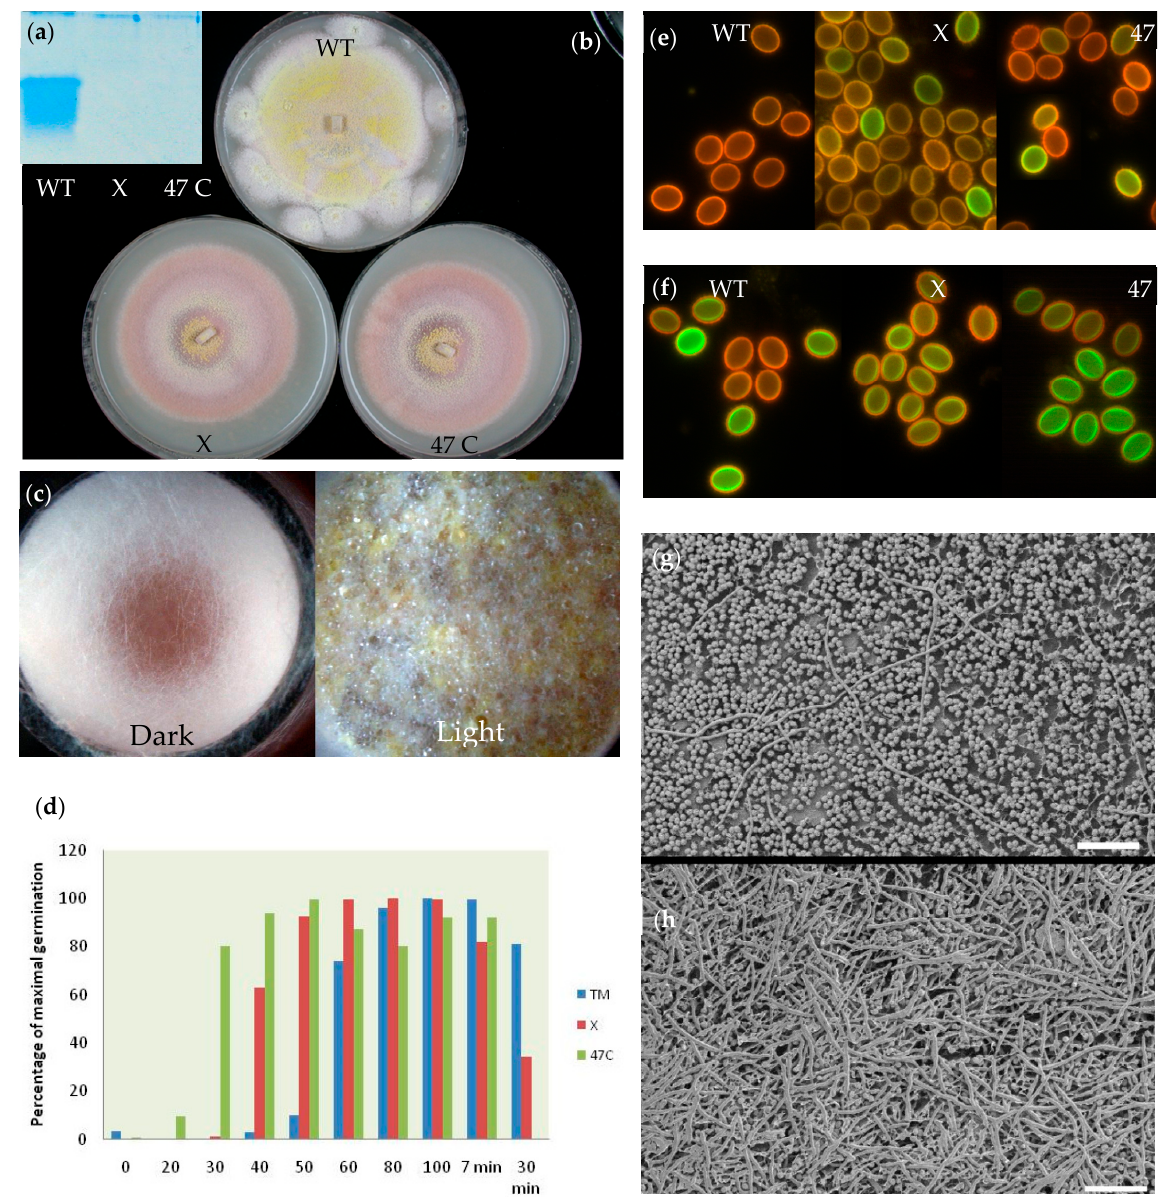
Figure 5. Properties of ICARUS mutants ( a – h ) ( a ) No protein was observed in the supernatant of mutant ascospores after heat activation. ( b ) Agar surfaces show different morphology of colonies of the wildtype in comparison with the mutant strains after 8 days of growth. Mutant colonies show later formation of ascomata (visible as yellow dots) and exhibit a red color due to a pigment which is also released into the agar. ( c ) Growth of mutant 47 C on oatmeal medium in the dark does not show the presence of ascomata after 8 days of incubation. Microtiter plates were wrapped in tin foil and kept in a closed box. ( d ) Colony count on plates that are inoculated with 400 ascospores of wild type and mutant strains that are heat treated for very short time periods (20–100 s) at 85° C. Note that survival of the mutant ascospores is less after 30 min of heat treatment. TM = Talaromyces macrosporus wild type strain; X and 47 C are the names of the mutant strains ( e ) Autofluorescence (red) and carboxy fluorescein staining (green) of the cell wall of ascospores without heat treatment. Mutant strains show spontaneous green staining of part of the spores, indicating a more permeable cell wall. ( f ) Staining of ascospore after a 1 min heat treatment at 85 °C, mutant ascospores all show a ring of staining, while part of the wild type ascospores do not exhibit green staining. ( g ) Numerous ascospores of the wildtype after 1 min of heat treatment and 19 h of incubation on malt extract medium at 25 °C. ( h ) Mutant strain 47 C show abundant formation of hyphae at the same time indicating that much more ascospores have germinated. Bar in ( g , h ) is 50 μ m.